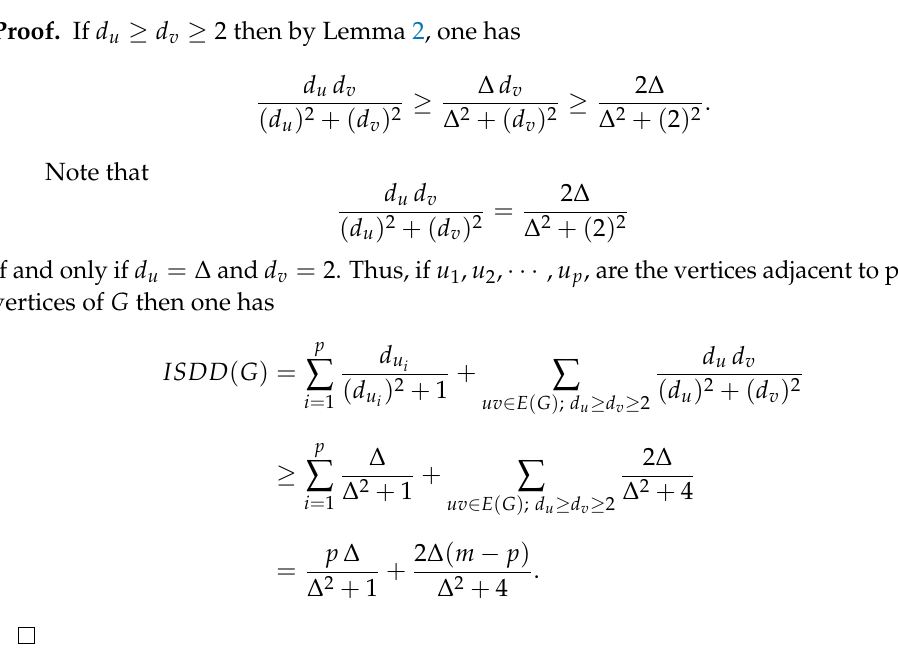
Figure 1. A graph attaining the bound mentioned in Lemma